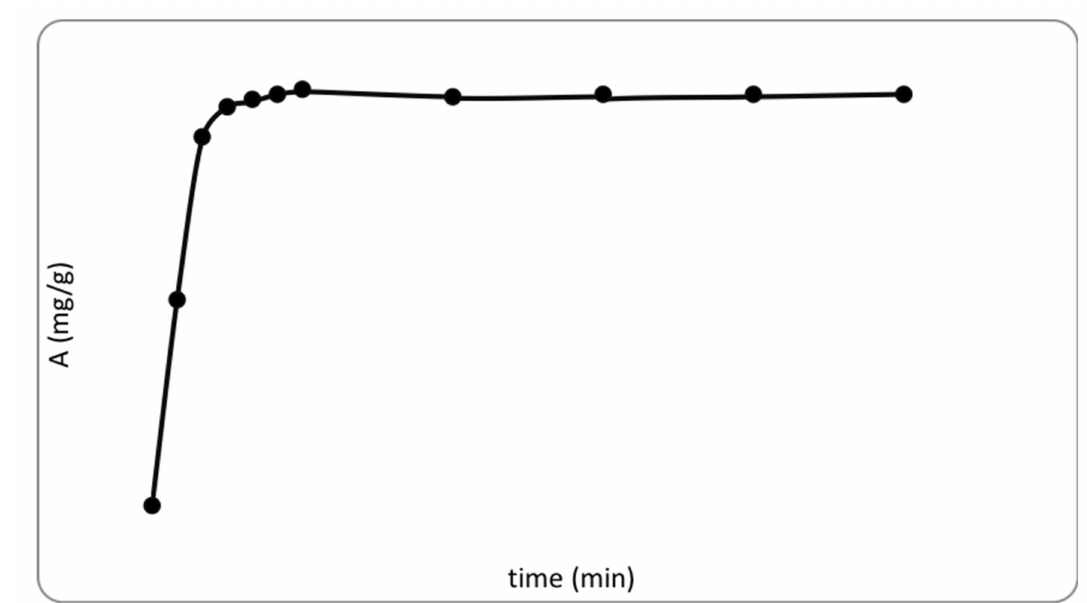
Figure 10. Sorption of fluoride ions from aqueous solution depending on